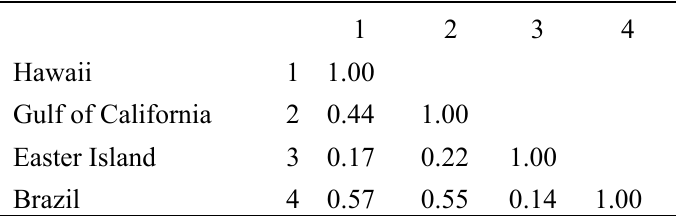
Table 2 . Similarity matrix between populations of D. crenulata